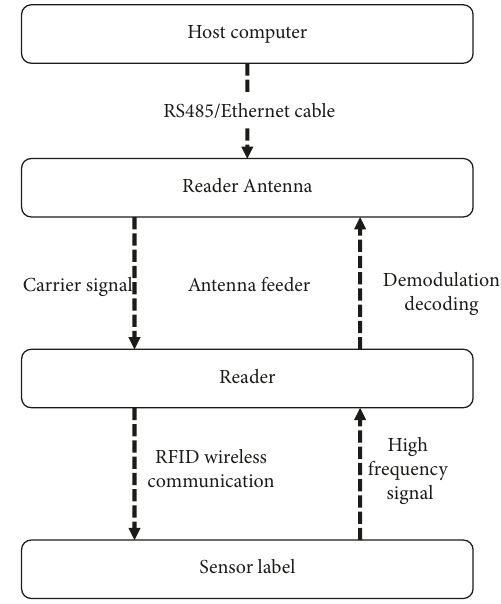
Figure 1: Basic working flow chart of the